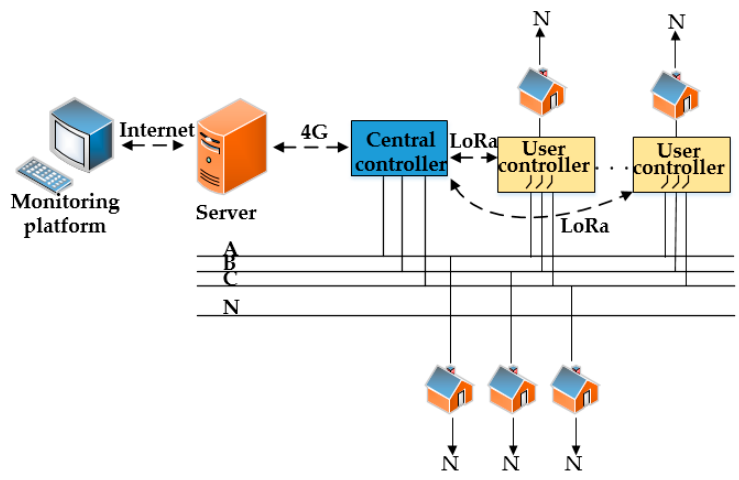
Figure 3. The overall frame of residential load transfer device.